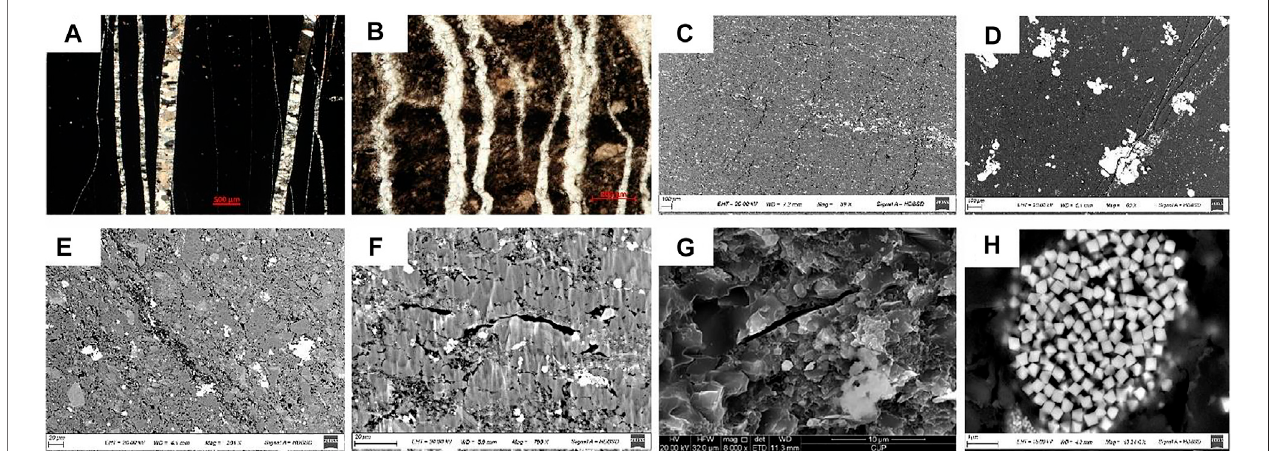
FIGURE 11 | Microfractures of Niutitang shale in Cen ’ gong block. (A) Multiparallel tectonic microfractures; (B) calcite- fi lled microfractures cutting off black argillaceous layers; (C) clay- fi lled microfractures; (D) tectonic microfractures cutting off pyrite; (E) interlayer microfractures parallel to sedimentary laminations; (F) grain- margin microfractures along rock particles; (G) intergranular microfractures of clay minerals; (H) intergranular pores of